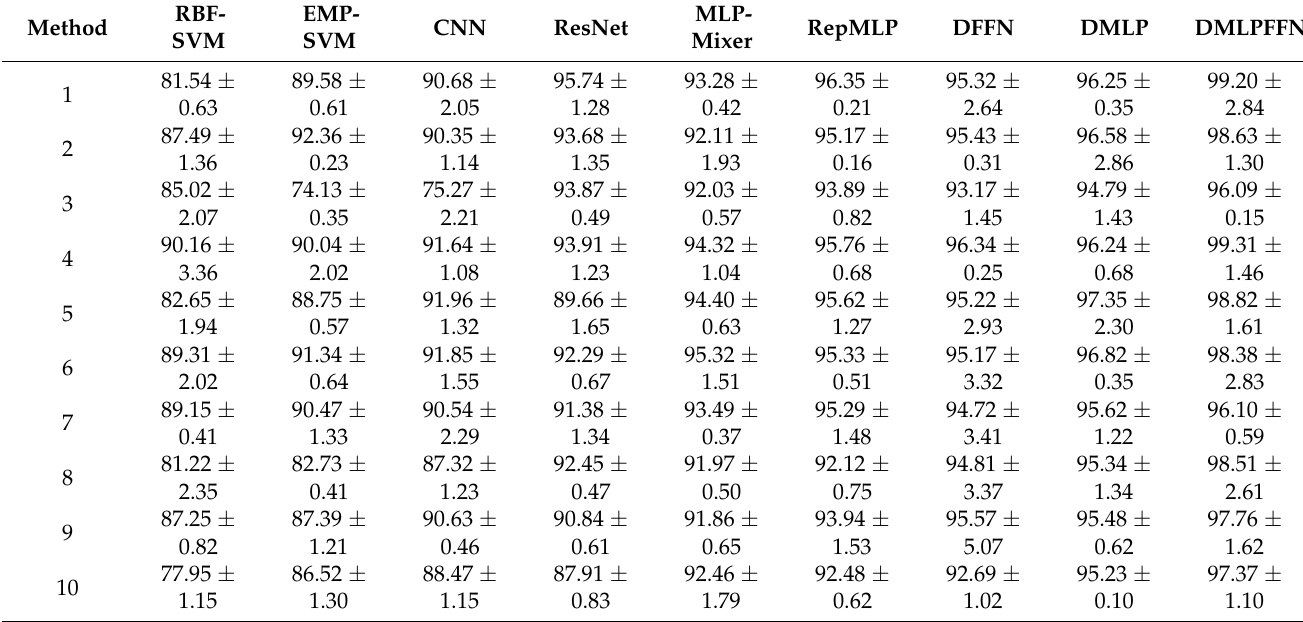
Table 4. Classification results on the Salinas dataset with the water absorption